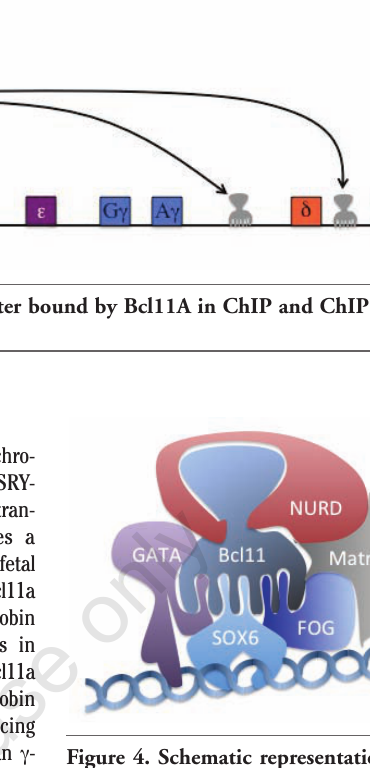
all members of the family with HPFH.